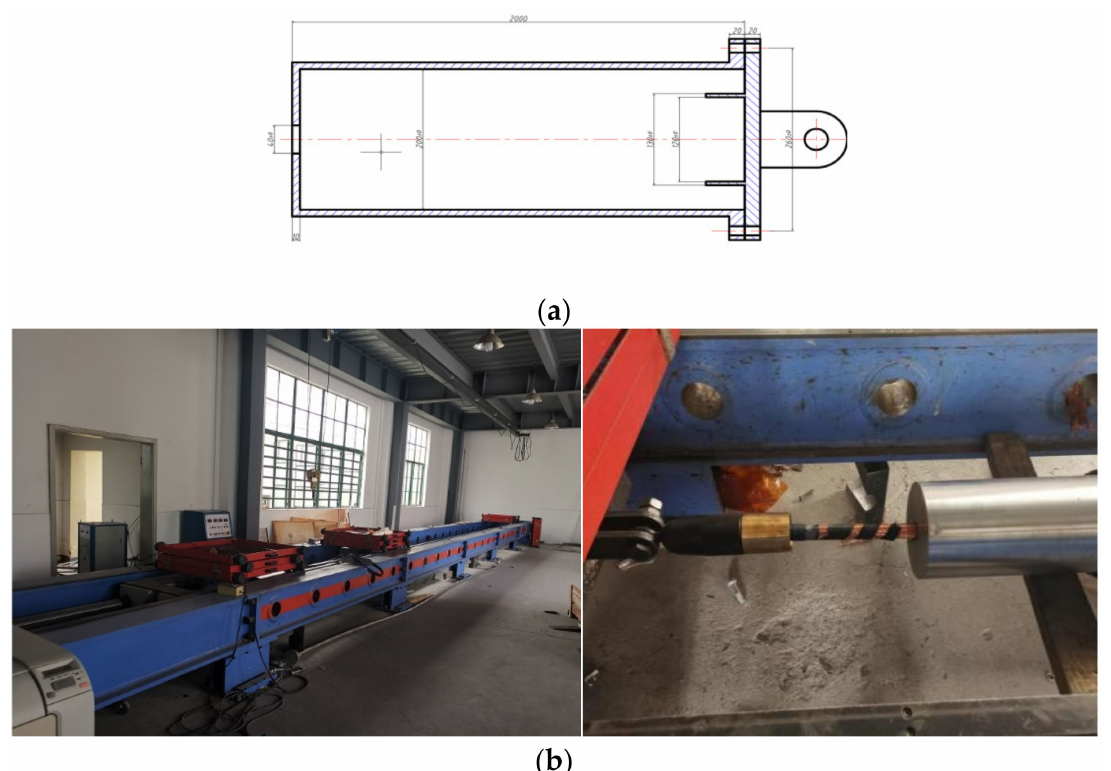
Figure 5. ( a ) Experimental tool (cable fixed inside before the experiment began). ( b ) Experimental fixture and mold, and tensile test